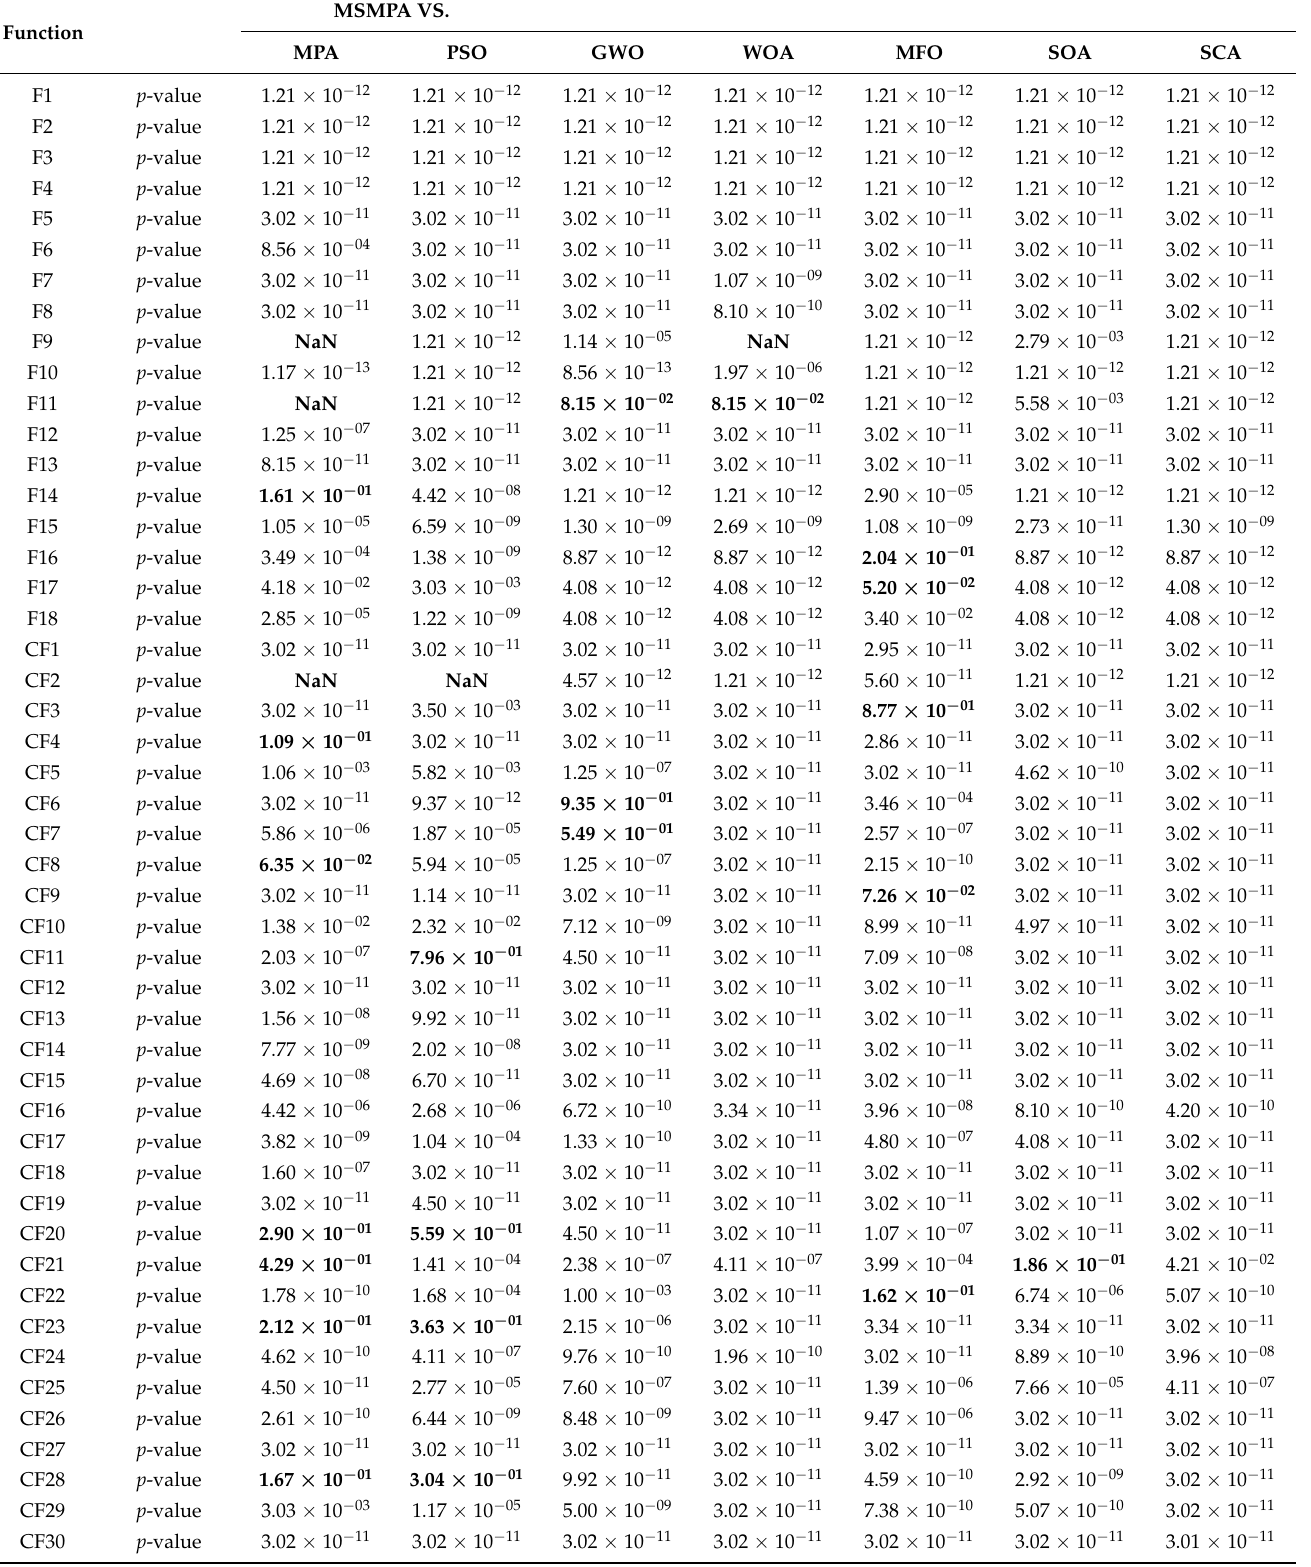
Table A3. p -values obtained from Wilcoxon’s rank sum test for MSMPA and other algorithms.